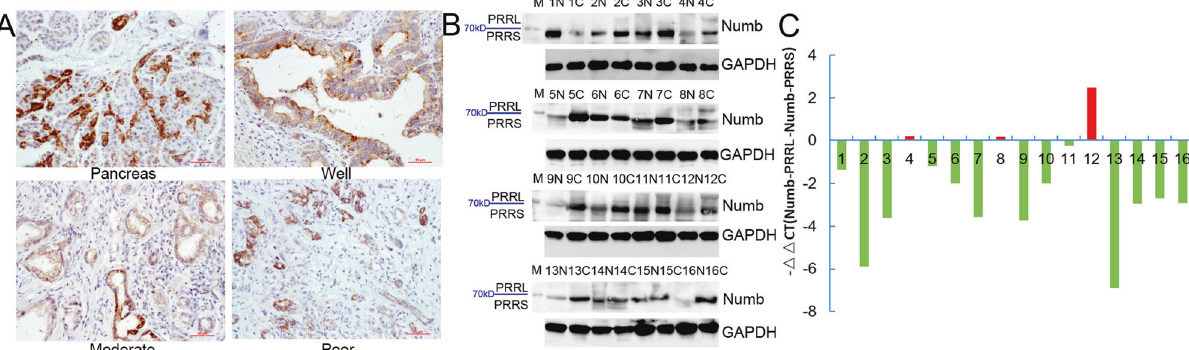
Fig. 1 Total Numb protein and Numb-PRRL expression in PC tissues. A Total Numb protein expression in normal pancreas, well-to-poor differentiated PC tissues. B , C Numb-PRRL and PRRS protein ( B ) and mRNA ( C ) expression in 16 cases of PC and paired normal